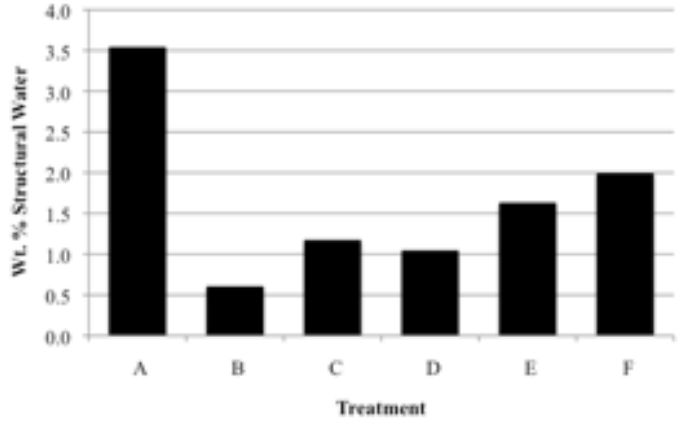
Figure 9. Average weight percent structural water (from TGA analysis) in